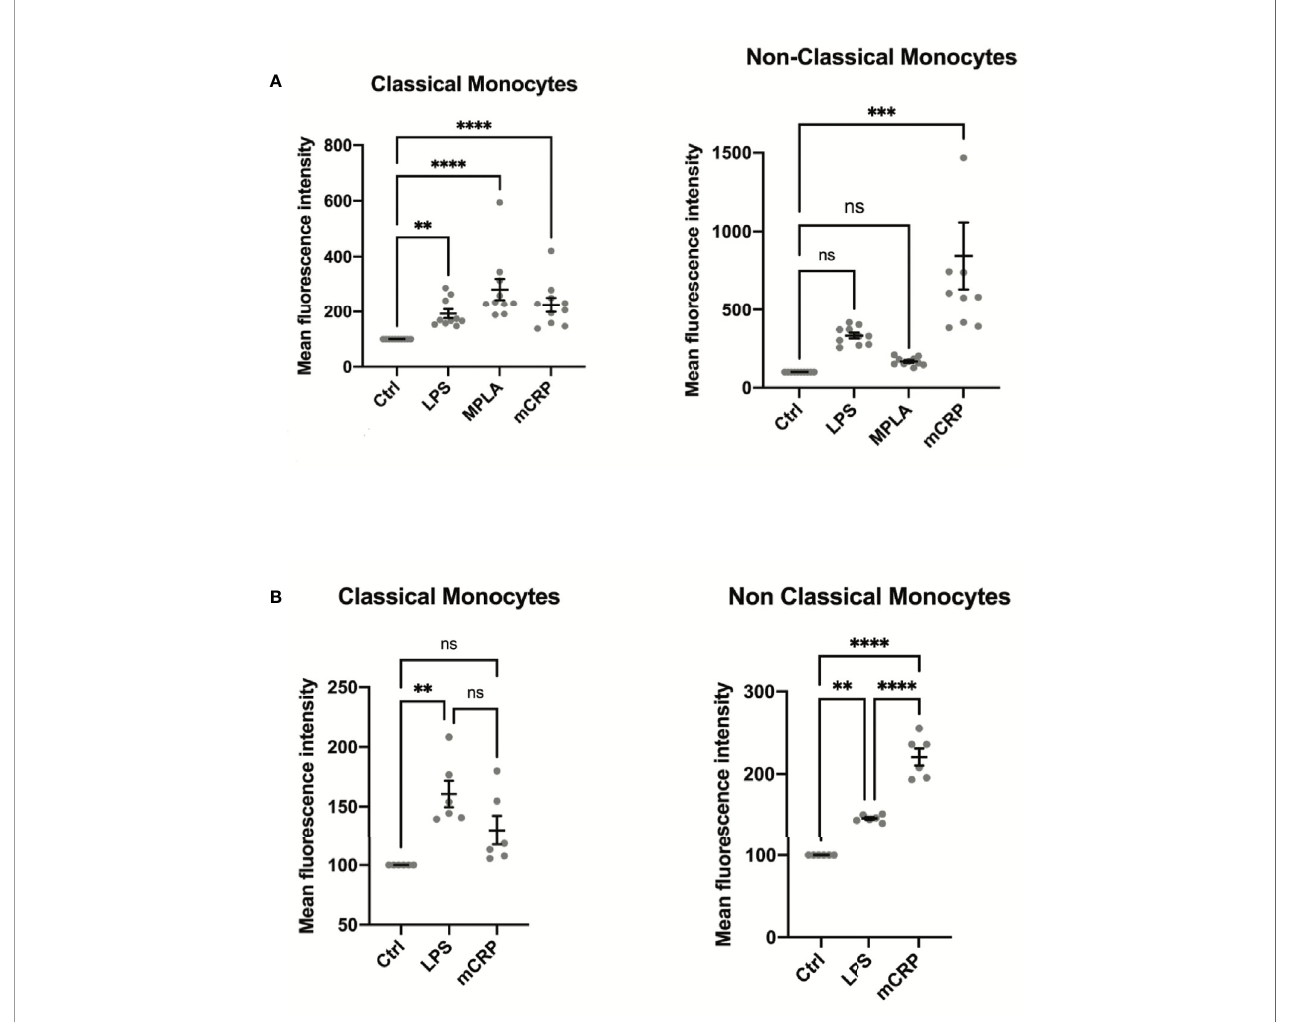
FIGURE 3 | (A) Monocyte activation state was assessed in whole blood samples of ten healthy individuals stimulated with PBS (control), LPS, MPLA, and mCRP for 15 minutes. An increase in MAN-1 expression demonstrated cell activation. The MFI for MAN-1 of the respective control sample was set as 100. Monocyte activation levels assessed by MAN-1 expression revealed to be highly subset-speci fi c after incubation of the cells with mCRP, whereas stimulation of monocytes with LPS and MPLA led to a general increase in monocyte activation. (B) Whole blood samples of six Wistar rats were analyzed after incubation with PBS (control), LPS, MPLA, and mCRP for 15 minutes, respectively. An increase in CD11b expression demonstrated cell activation. The MFI of the respective control sample was set as 100. Monocyte activation levels assessed by CD11b expression were also highly subset-speci fi c following the pattern seen in human samples, which con fi rmed the interspecies transferability of the fi ndings. ns, not signi fi cant; **p < 0.01; ***p < 0.001; ****p <